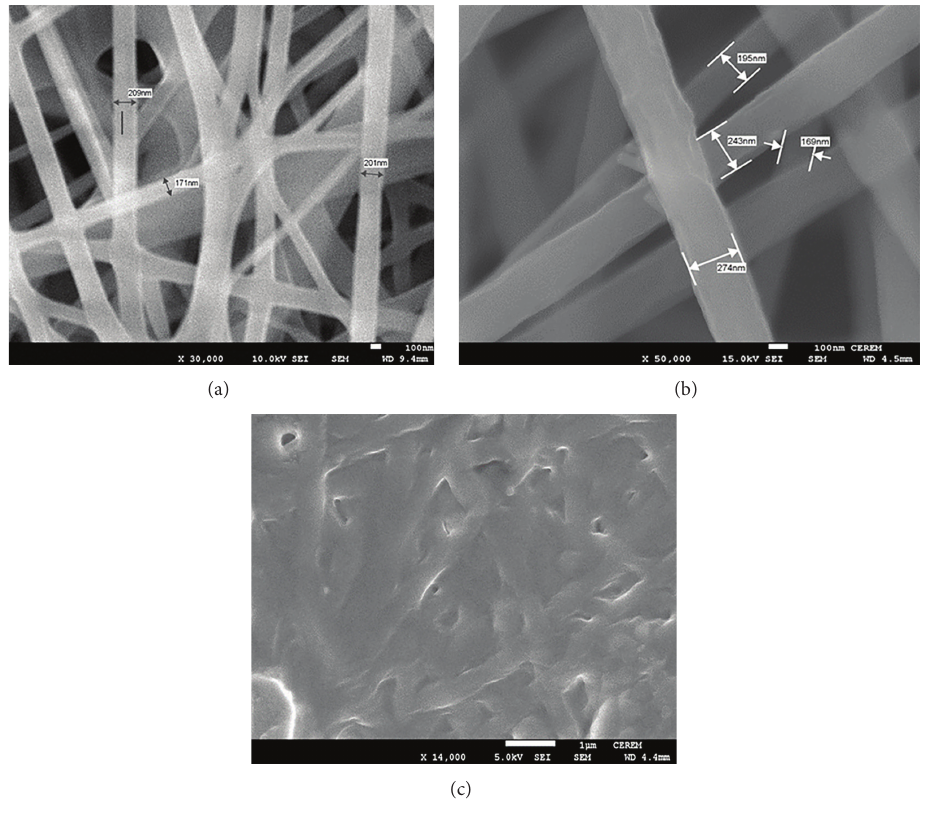
Figure 1: Typical SEM micrographs of the PVA electrospun nanofibers: (a) as spun; (b) heat treated at 𝑇 𝑔 (85 ∘ C, which is ∼ 0.5 𝑇 𝑚 ); and (c) heat treated at ∼ 1.65 𝑇 𝑔 (140 ∘ C, which is ∼ 0.7 𝑇 𝑚 ).